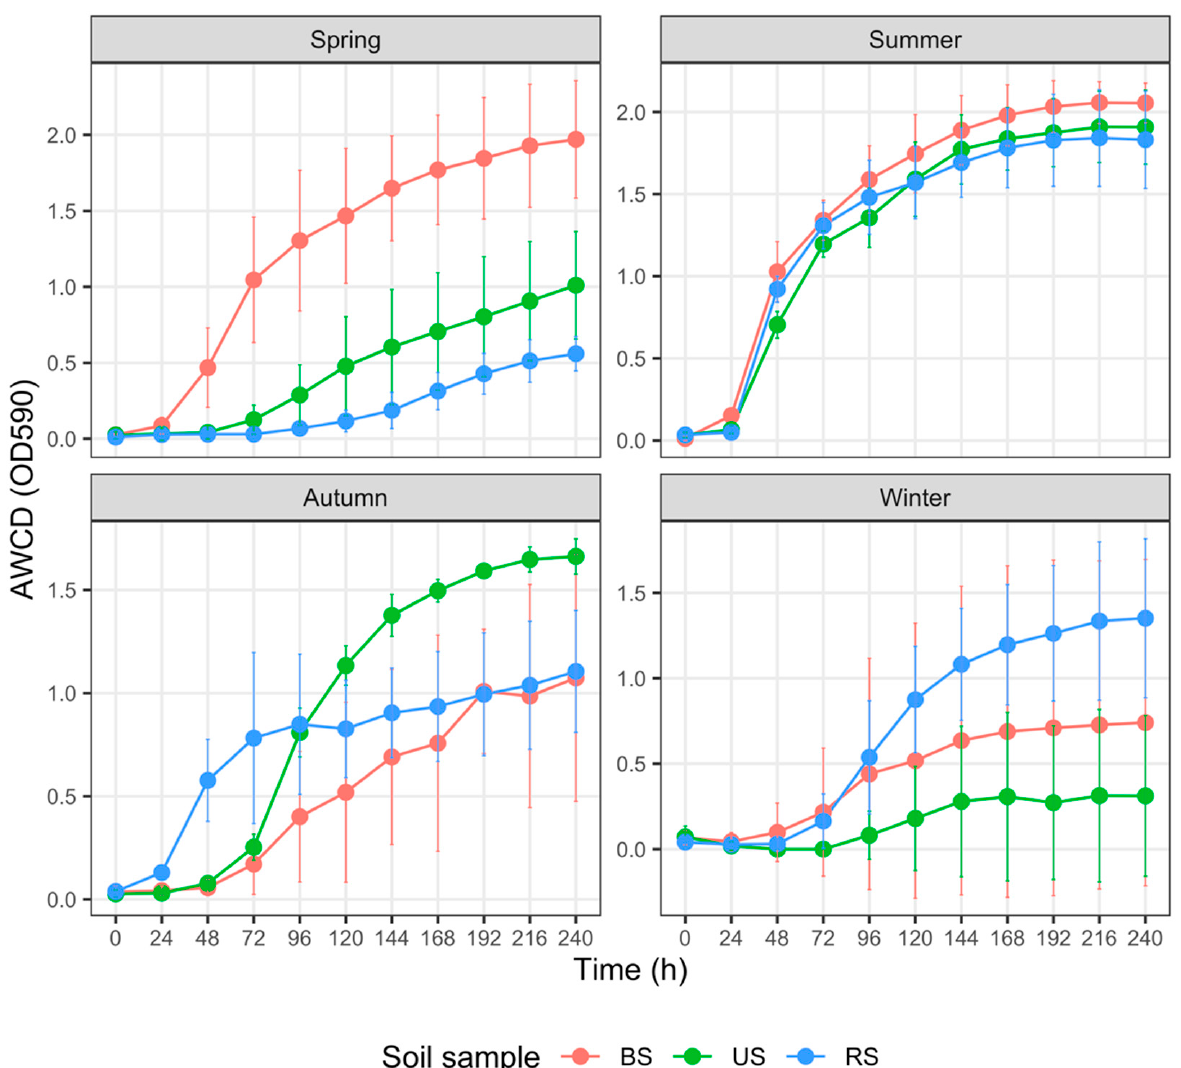
Figure 7. Variation in the average well color development (AWCD) of amino acids among three groups of soil samples collected in different seasons. The error bar represents the mean ± SD ( n = 3). AWCD 240 of each soil sample was compared using the Kruskal–Wallis test. Abbreviations: BS—bulk soil; RS—rhizosphere soil; US—uncultivated soil.